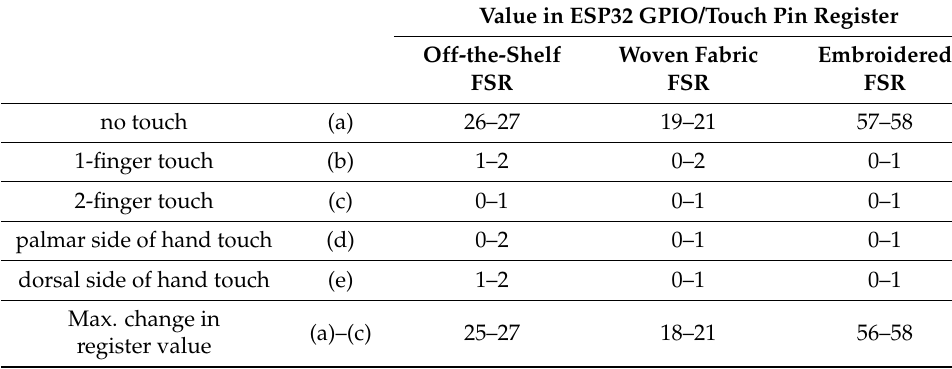
Table 4. Performance comparison of the three FSRs shown in Figure 3.